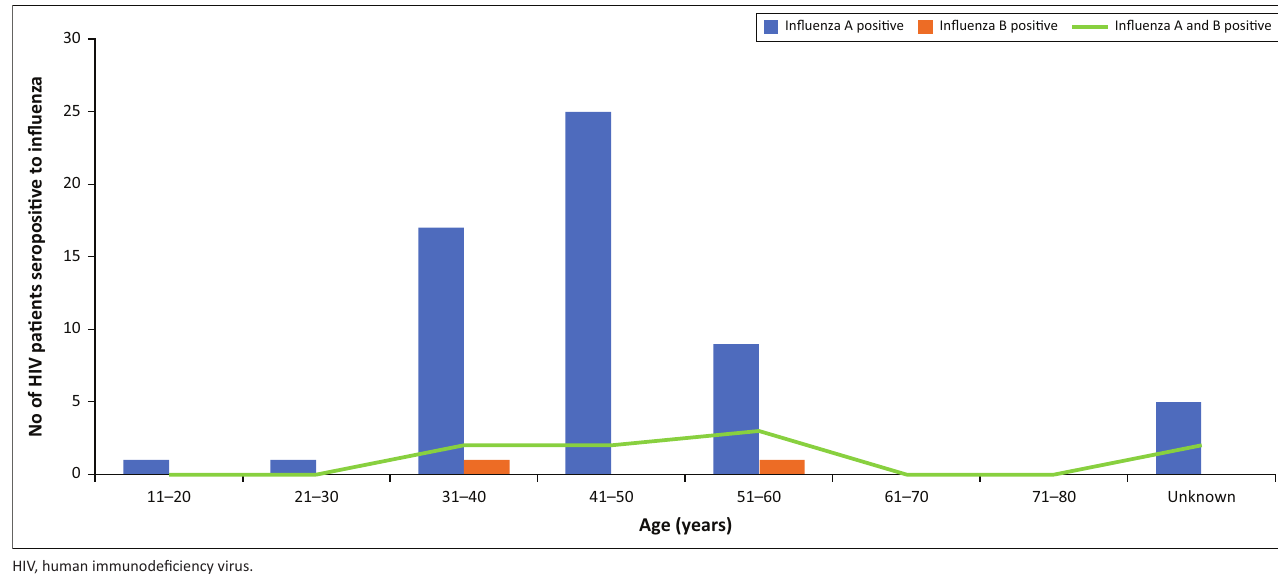
FIGURE 1 : Age (years) distribution of HIV patients seropositive to influenza in 2018 in a university-based HIV clinic in Lagos,